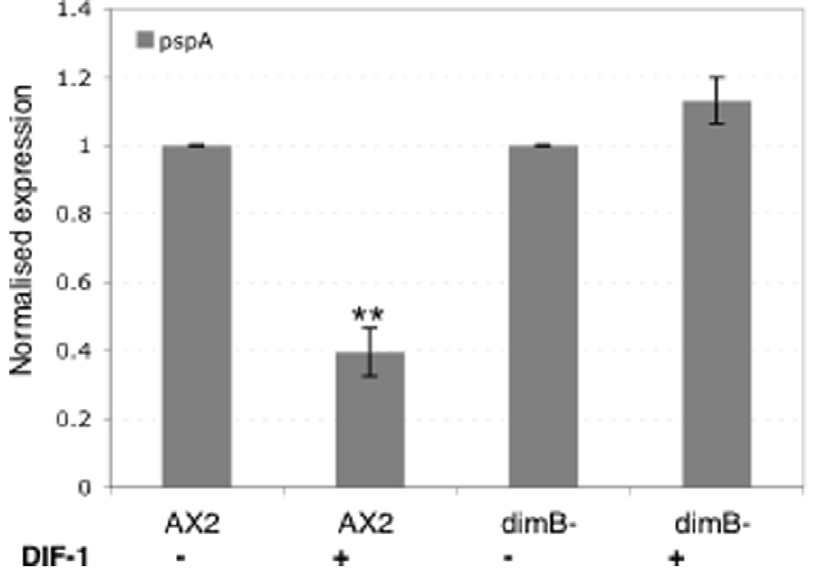
Figure 5. DIF repression of pspA expression. Disaggregated cells at the mound stage were incubated in the presence or absence of DIF-1. Q- PCR analysis of RNA samples was performed and the data is plotted as the mean of 3 independent biological repeats each performed in triplicate. The data is normalized to the expression level of Ig7 , a constitutively expressed gene and that for each strain is normalized to the value without DIF. The mean results are shown with their standard deviations.